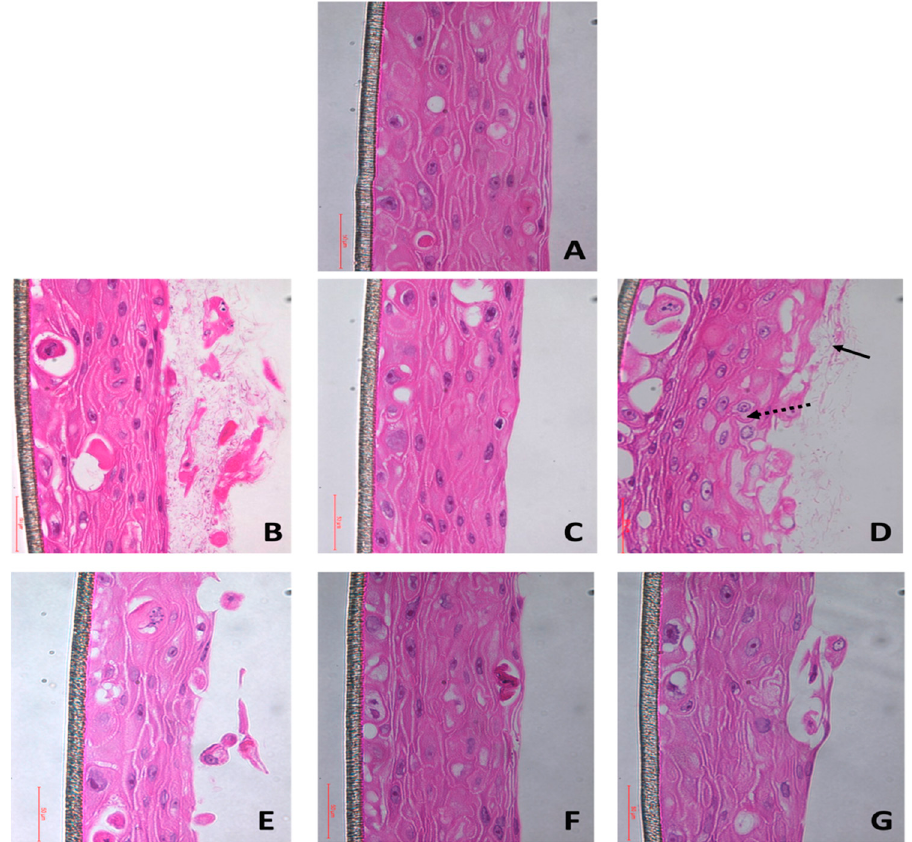
Figure 1. Cross-sectional images (x50) of the ( A ) uninfected control and ( B–G ) infected tissues stained with hematoxylin and eosin. Images B, C, and D represent tissues infected with Candida albicans SC5314, Enterococcus faecalis OG1RF, and Candida albicans SC5314 + Enterococcus faecalis OG1RF, respectively, while images E, F, and G represent tissues infected with Candida albicans BF1, Enterococcus faecalis P52S, and Candida albicans BF1 + Enterococcus faecalis P52S. The black arrow indicates the hyphae and the dotted arrow represents the loss in tissue integrity. Note that the tissues infected with the reference strain of C. albicans (SC5314) show dense and numerous hyphae, compared to the clinical strain (BF1), which does not demonstrate hyphal formation. Surface erosion of the mucosal tissues in all the tissues infected with C. albicans (B, D, E, and G) is apparent, compared to the control